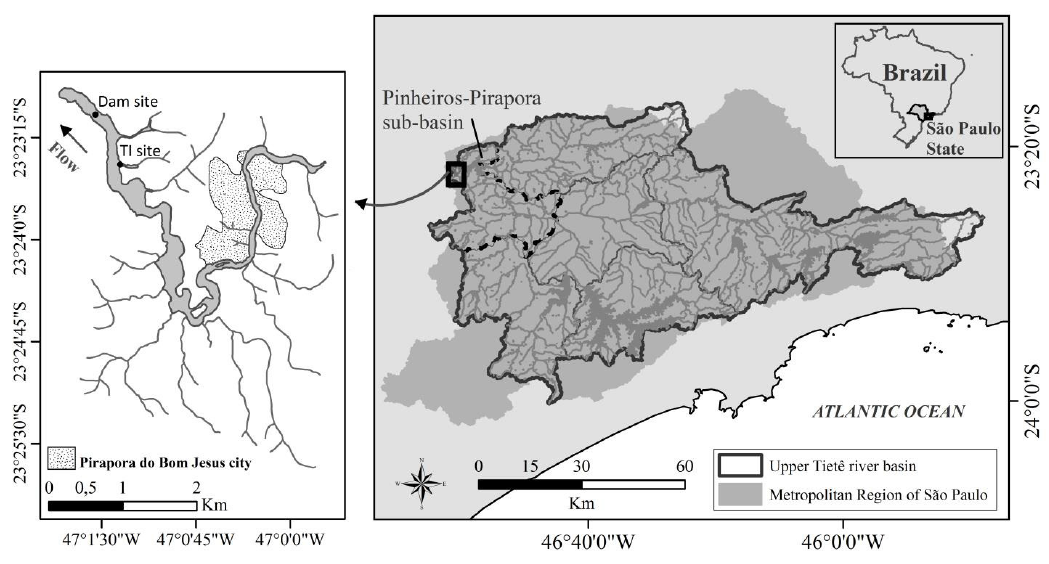
Figure 1. Study area and location of sampling